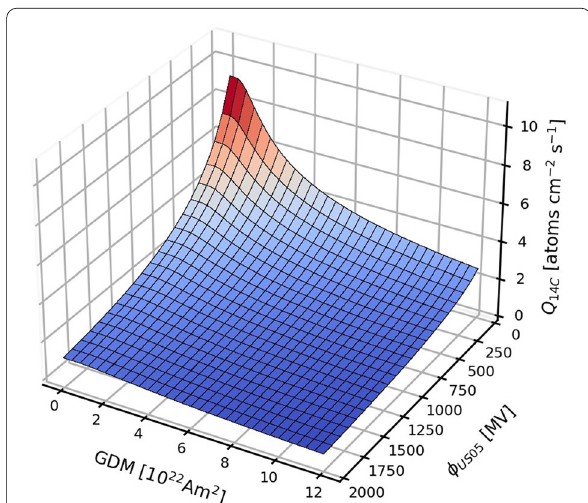
Fig. 3 Global production rate of 14 C as a function of solar modulation potential and GDM. The graph is based on the model of Kovaltsov et al. (2012)